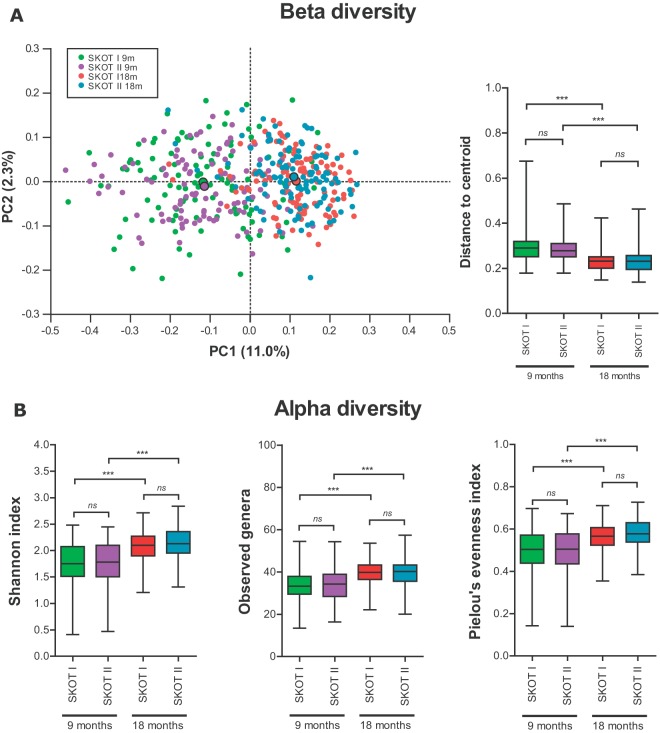
Gut microbial beta and alpha diversity is independent of maternal obesity but changes over time. (A) PCoA plot based on Bray-Curtis dissimilarity, with the centroid for each group shown with a black boarder. The distance to the group centroid for each point provides a measure of homogeneity of variance, used to estimate beta diversity. PC1 and PC2, principal coordinates 1 and 2, respectively. (B) Alpha diversity measures as estimated by the Shannon index, observed genera, and Pielou’s evenness index. Boxes indicate 25th to 75th percentiles, with mean values marked as a line and whiskers indicating minimum and maximum values. ns, not significant; *, P < 0.05; **, P < 0.01; ***, P < 0.001 (according to Tukey’s honestly significant difference test for beta diversity and paired [within cohorts, across time points] or unpaired [across cohorts at the same time point] t tests for alpha diversity measures).